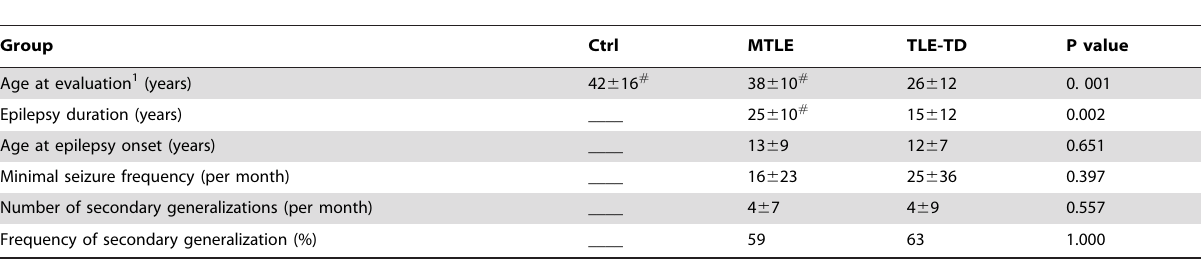
Table 1. Clinical history of patients with TLE (MTLE and TLE-TD) and Ctrl cases.